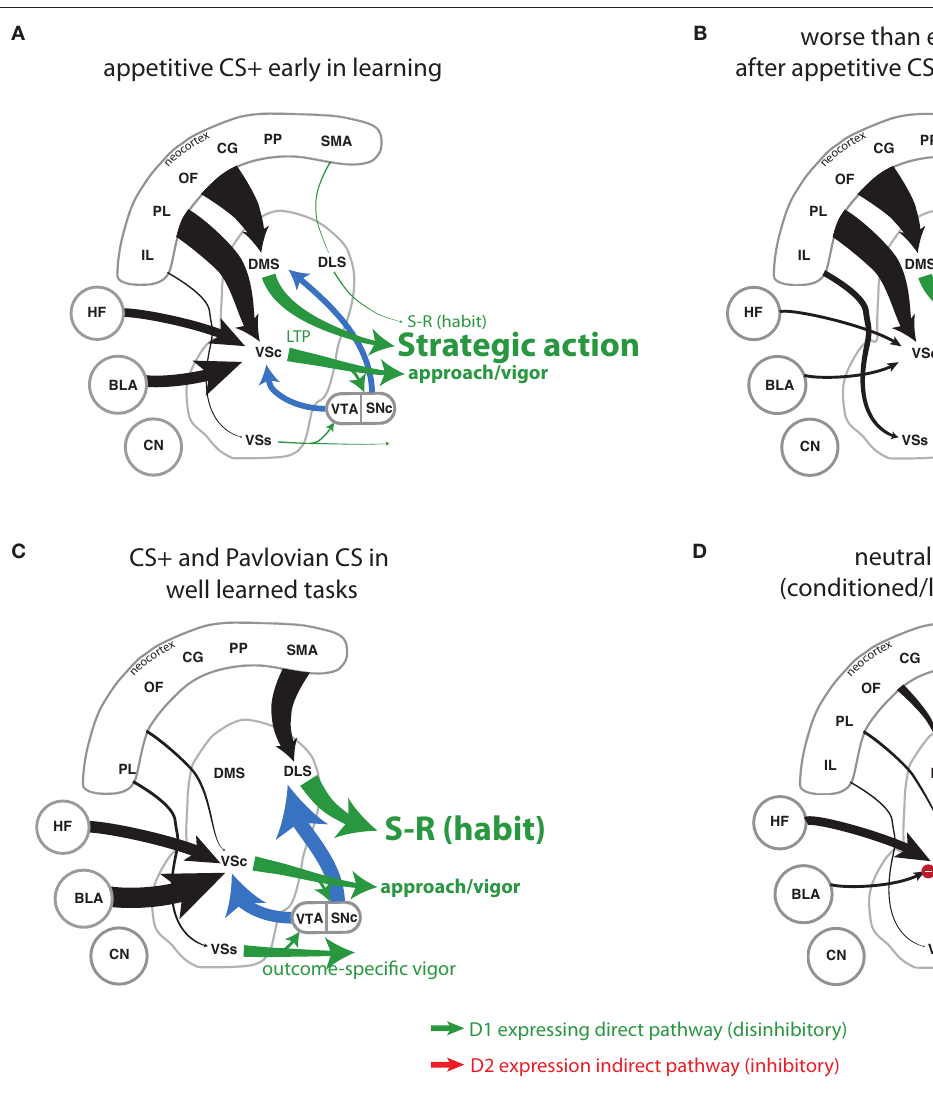
FIGURE 4 | Simple conceptual model of cortico-limbic processing in different scenarios. (A) Presentation of a conditioned stimulus (CS + ) early in learning evokes activity in amygdala, thereby triggering VSc activity and elevated dopamine (blue arrows) to engage approach and invigorate strategic actions in DMS. Following reward, direct pathway circuits undergo LTP via dopamine effects on D1 receptors. Many repetitions of such responding will eventually lead to habitual responding in tasks that can be solved by this response strategy. (B) Dopamine levels drop when expected rewards fail to occur, thus increasing sensitivity of striatal SPN to cortical input so as to alter response strategy. LTP ensues in the associated indirect DLS pathway to start the process of conditioned inhibition for that response, while LTD occurs on the associated DLS, DMS, and VS circuits that engaged